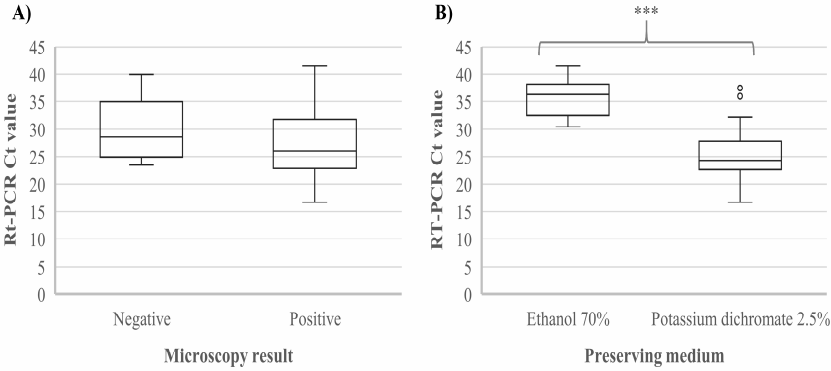
Figure 1. Real-time PCR cycle threshold values according to ( A ) microscopy results (negative vs. positive for Giardia duodenalis ) and ( B ) preserving medium (ethanol 70% vs. potassium dichromate 2.5%). *** indicates p < 0.001.